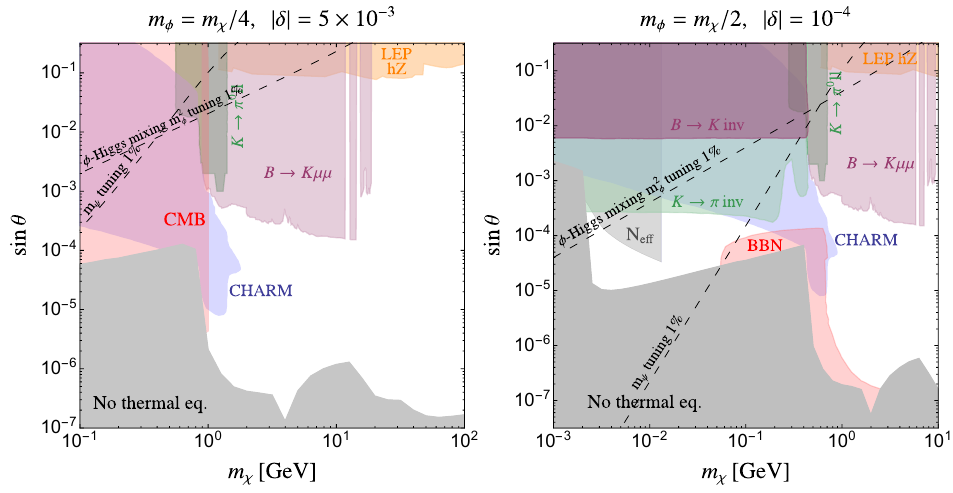
Figure 8 . Phenomenology of a dark sector weakly coupled to the SM. Both panels show current constraints as a function of the DM mass, m (cid:31) , and the size of the mixing between the dark sector scalar and the SM Higgs boson, sin (cid:18) . The left panel shows the e(cid:11)ect of a lighter mediator, (cid:30) , and larger DM mixing, (cid:14) , compared to the heavier and more weakly coupled case in the right panel. The gray shaded area at the bottom of the plot covers values of the mixing for which the dark sector is not in equilibrium with the SM at freeze-out. The other bounds are discussed in the text and come from CMB measurements from Planck [64], BBN [77, 78], meson decays [79{86], CHARM [87], and LEP [88, 89]. In every point of the plot (cid:1) is (cid:12)xed to reproduce the observed relic density. The remaining parameters are set to y = e i(cid:25)= 4 , m (cid:30) = m (cid:31) = 4 ( m (cid:31) = 2), and (cid:14) = 5 (cid:2) 10 (cid:0) 3 e i(cid:25)= 4 (10 (cid:0) 4 e i(cid:25)= 4 ) in the left ( right )